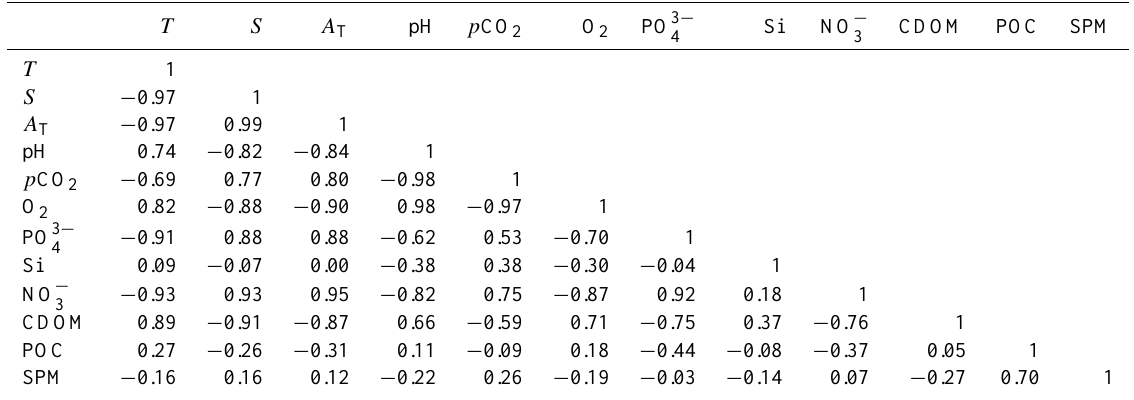
Table 2. Correlation matrix of the environmental parameters observed in the Buor-Khaya Bay in September 2005 ( n = 43).